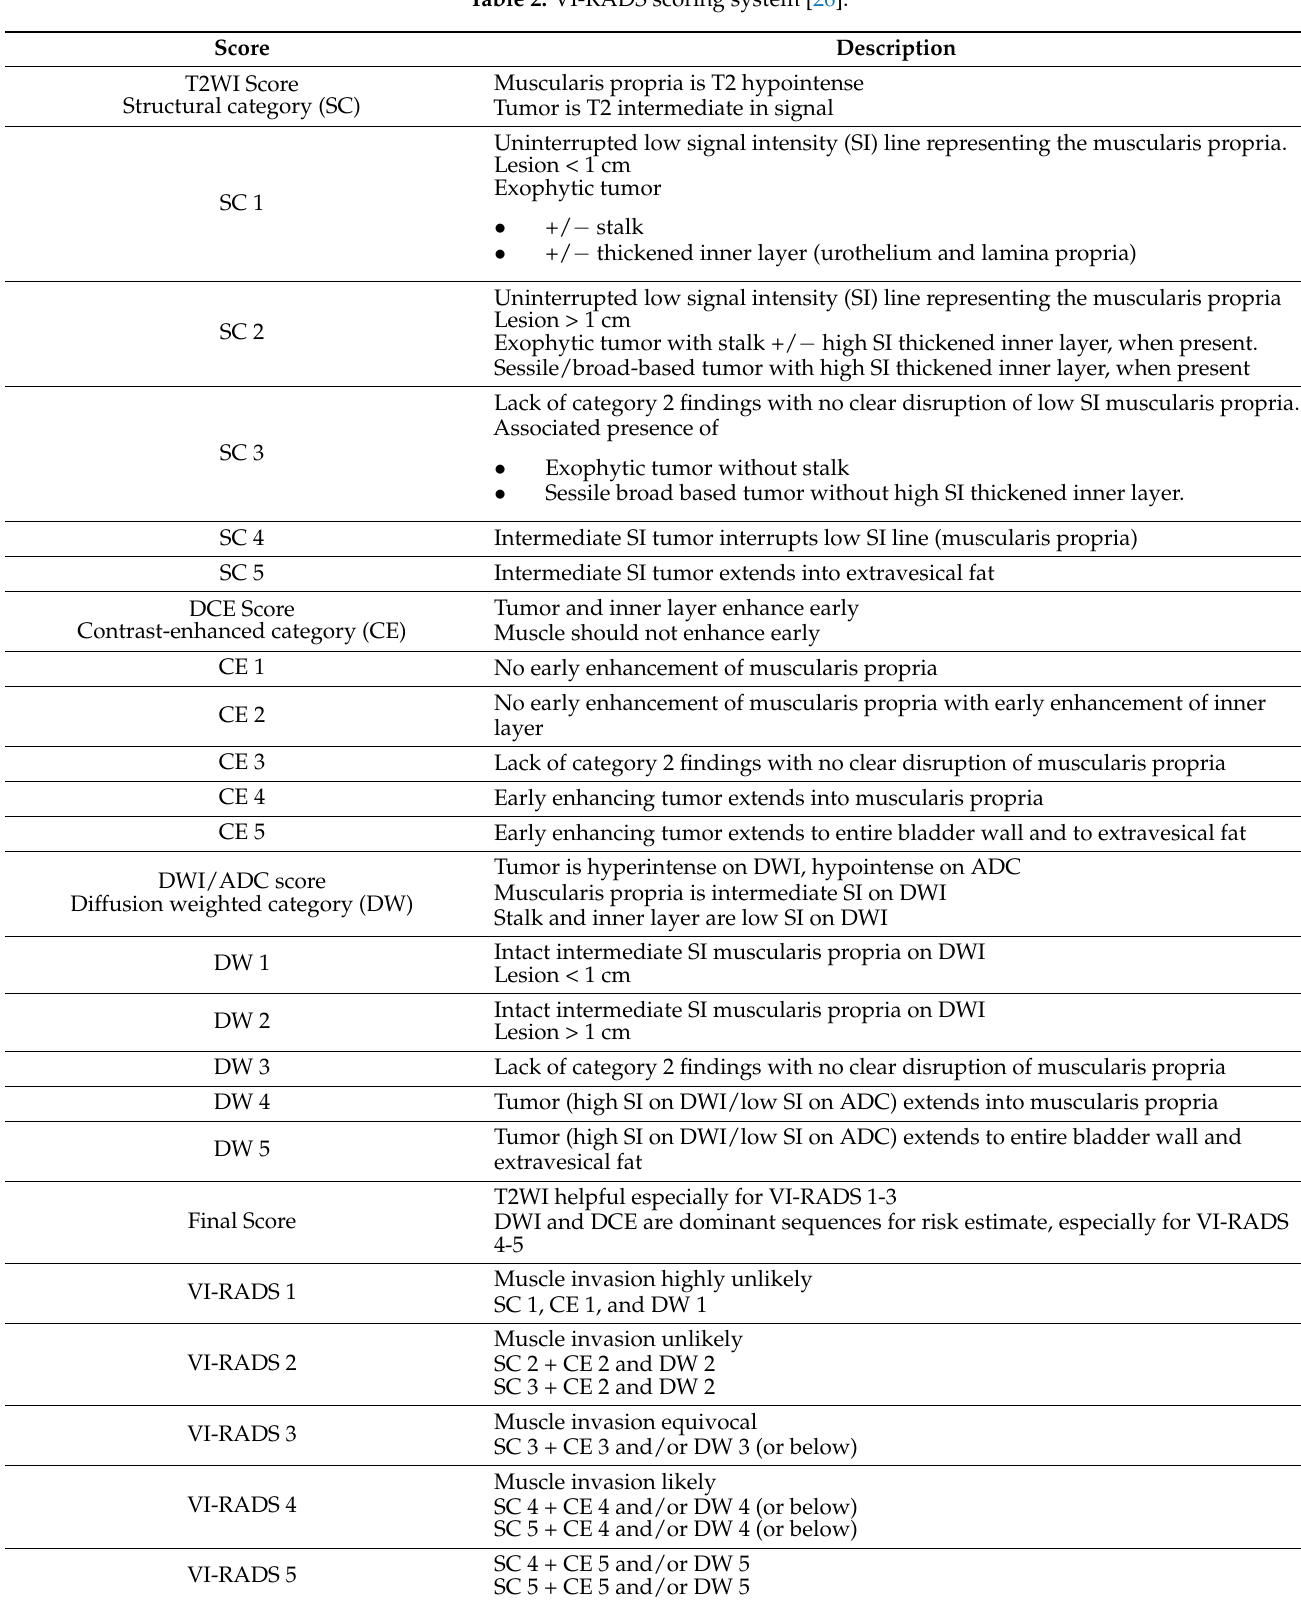
Table 2. VI-RADS scoring system